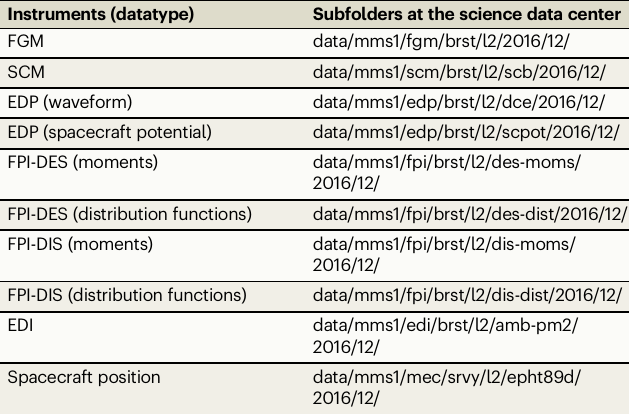
Table 2 | List of subfolders for MMS1 data at the Science Data Center Instruments